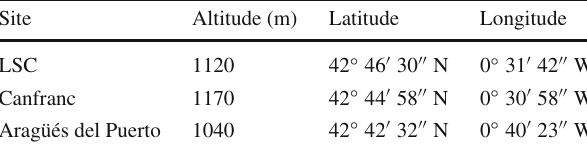
Table 6 Correlation coefficients (2015–18) between the four inside variables, recorded underground by our radon monitors, for the halls A, B and C of LSC and the outside variables recorded by the AEMET stations of Canfranc (temperature and relative humidity) and